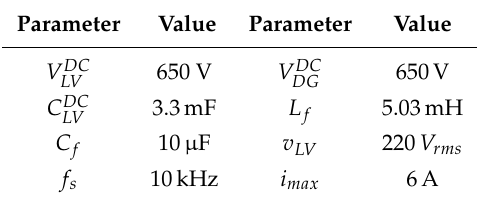
Table 3. Experimental setup parameters.